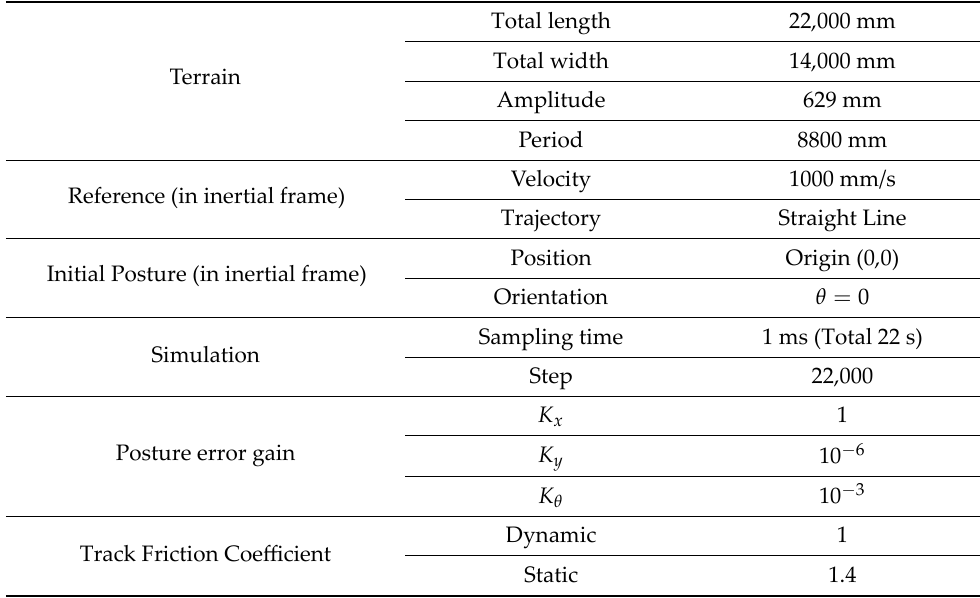
Figure 8. Reference trajectory and coordinate frames in the RecurDyn simulation model. Table 3. Parameters of rough terrain and posture tracking controller for simulation.